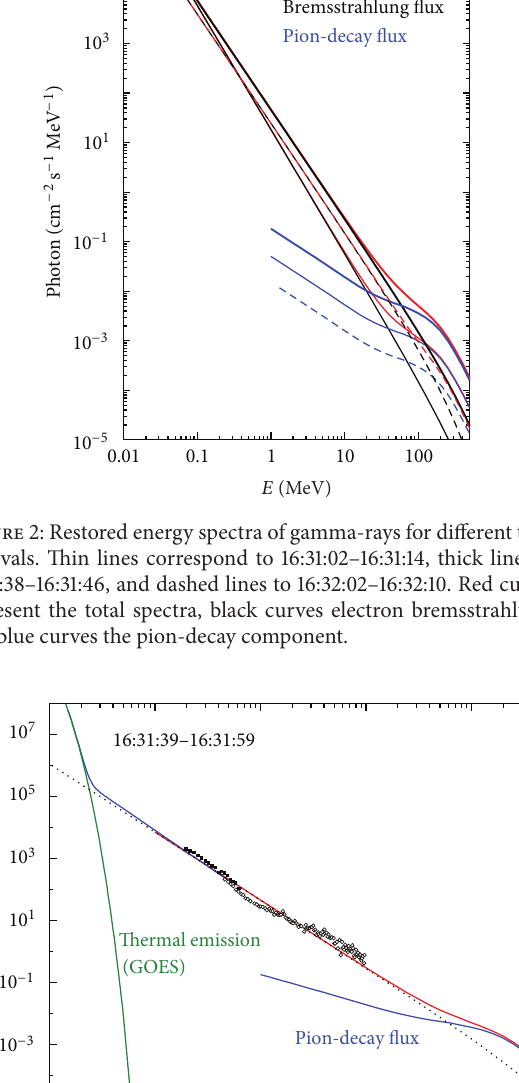
𝐻𝛼 ranging from 09:40 to 18:00